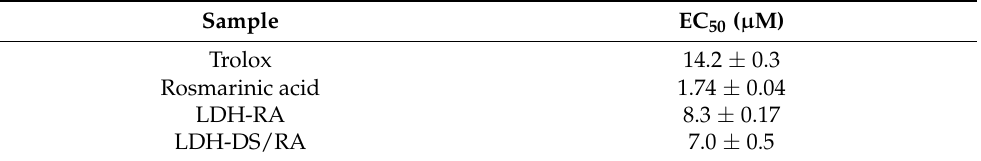
Table 2. EC 50 values of Trolox, rosmarinic acid, LDH-RA, and LDH-DS/RA.